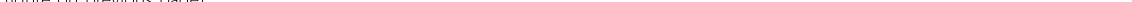
neurons in a 200 µm-wide fi eld of adult WT and cKI f/ + mouse neocortex ( n = 4, 5, and 3). Two-tail unpaired t -test is used to analyze the data. n.s. no signi fi cant difference; P < 0.05 (*), P < 0.01 (**), P < 0.001